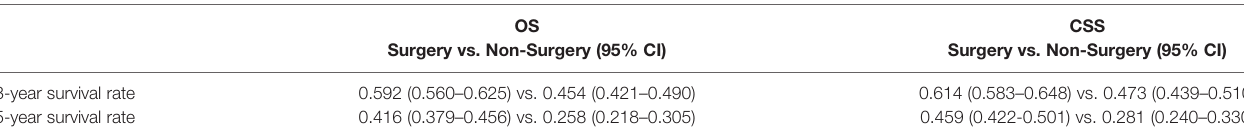
TABLE 4 | Comparison of patient survival rates between the two groups in the PSM cohort. OS CSS Surgery vs. Non-Surgery (95% CI)